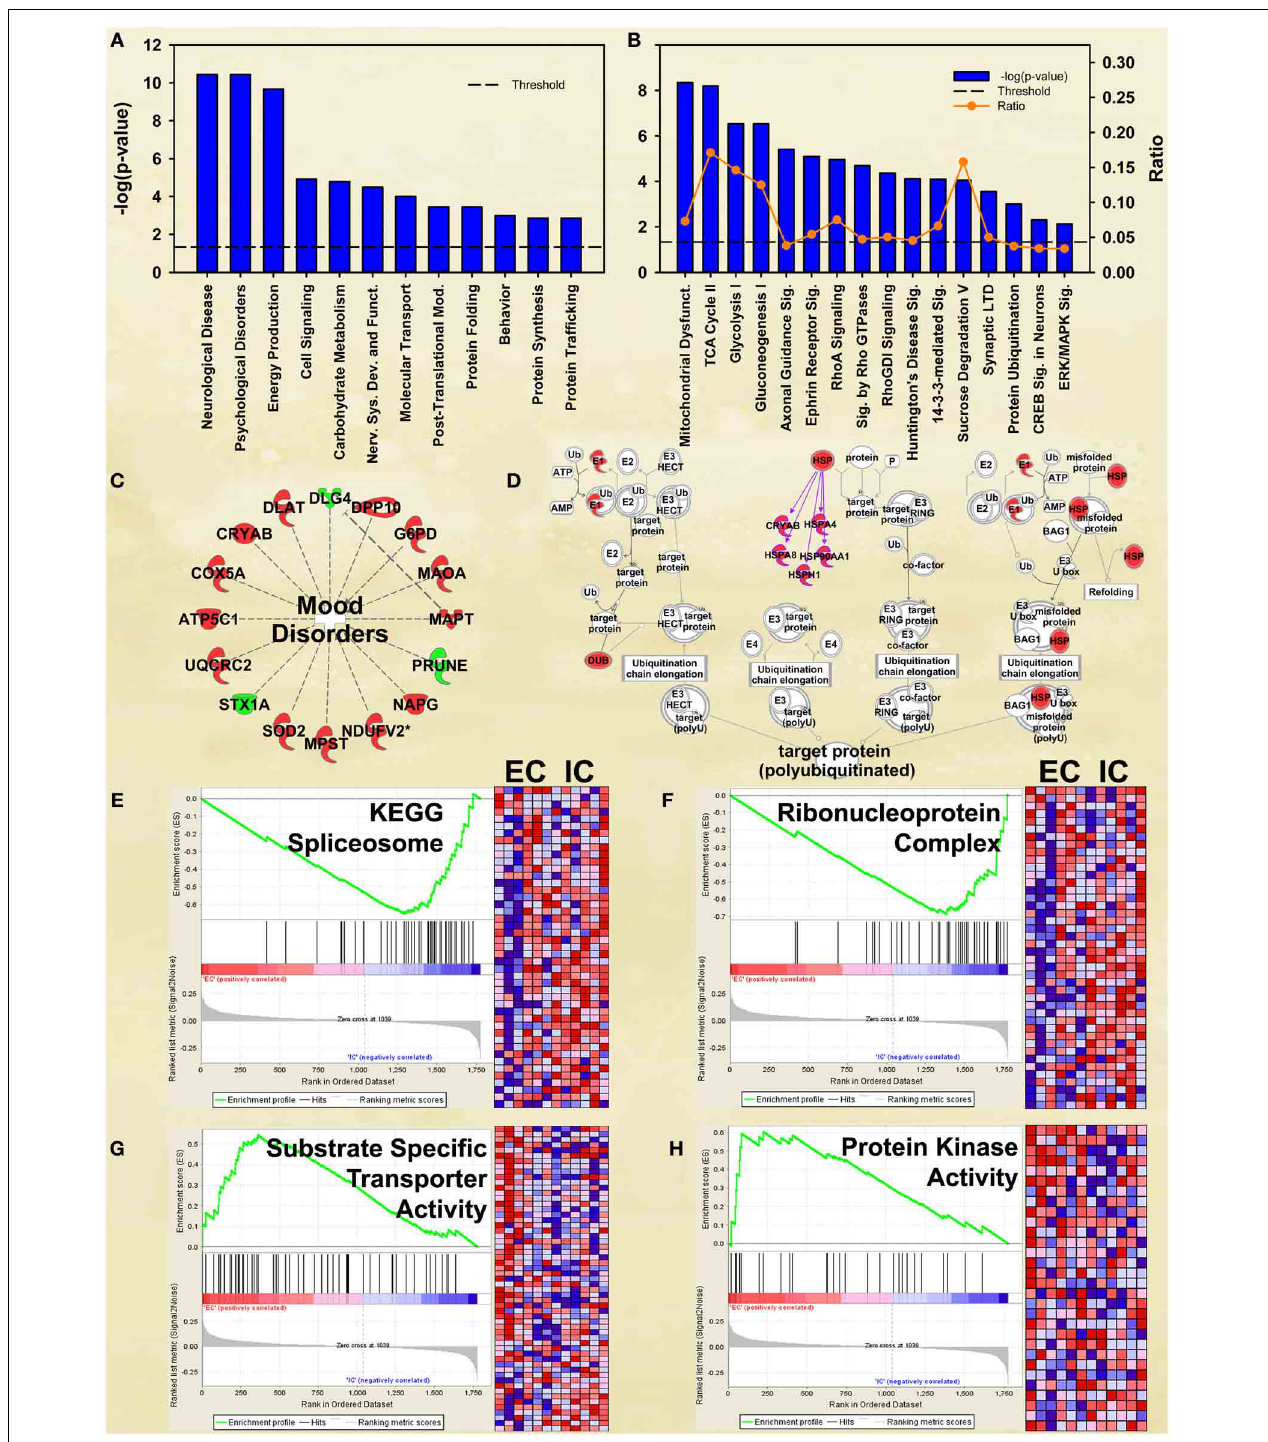
FIGURE 2 | IPA and GSEA findings for environmental enrichment main effect. A complete list of results can be found in Supplementary Materials, as can a complete list of all proteins in each pathway. (A) A selection of significant biological functions and diseases for environmental enrichment main effect, as determined by IPA. The y axis represents the − log( p ) value for each function/disease. (B) A selection of significant canonical pathways for environmental enrichment main effect, as determined by IPA. Orange line